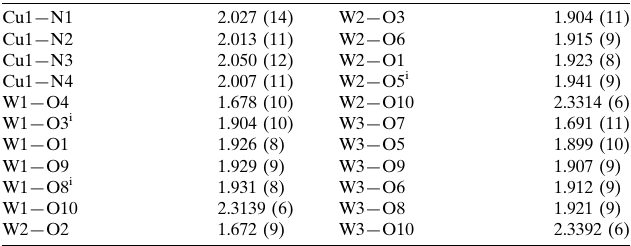
Selected bond lengths (A˚ ).